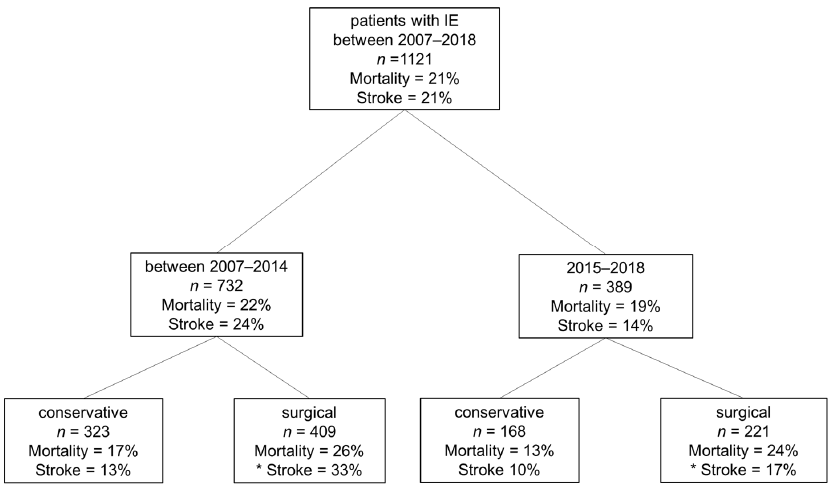
Figure 2. Flowchart of all patients with infective endocarditis treated in our center between 01/2007 and 03/2018 and the incidence of in-hospital mortality and stroke. IE: infective endocarditis; * Stroke: pre-operative and post-operative.